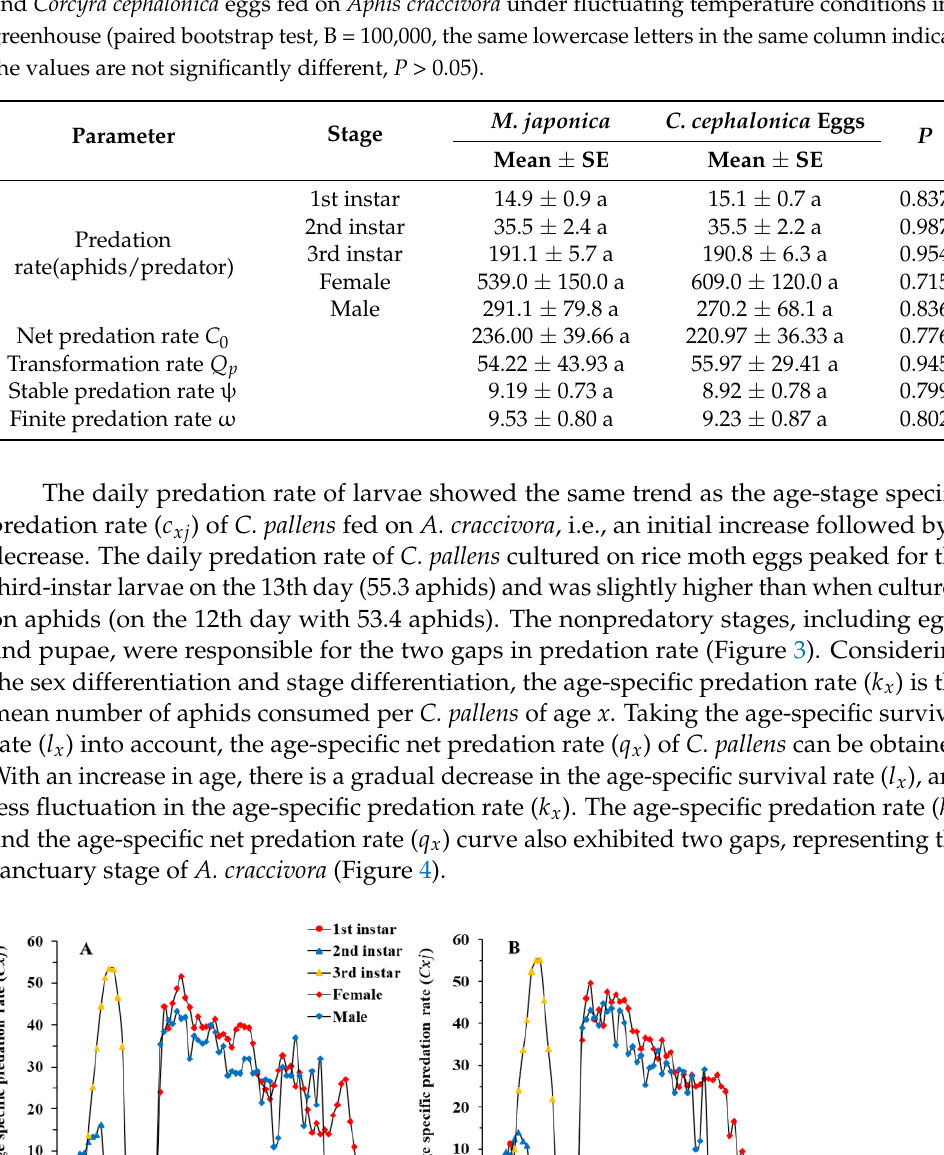
Figure 4. Age-specific survival rate ( 𝑙 𝑥 ), age-specific predation rate ( 𝑘 𝑥 ), and age-specific net preda- tion rate ( 𝑞 𝑥 ) of Chrysopa pallens ever cultured on Megoura japonica ( A ) and Corcyra cephalonica eggs ( B ) under fluctuating temperature conditions in a greenhouse. The mean and standard errors of the predation rate parameters estimated by means of the bootstrap technique [63] are listed in Table 3. There were no significant differences in the main predation rate parameters between both treatments after incorporating the survival rates and predation rates. The net predation rate ( 𝐶 0 ) of C. pallens cultured on aphid food (M. japonica ) was higher than when cultured on rice moth C. cephalonica eggs. The transformation rates (𝑄 𝑝 ) of C. pallens cultured on aphid food ( M. japonica ) and rice moth C. cephalonica eggs were 54.22 and 55.97, respectively (Table 3). 4. Discussion The use of banker plants was developed to increase the effectiveness of BCAs in pest control [24,25]. Most studies on banker plant systems have focused on assessing the suit- ability of a plant species as a banker plant [63–65] or the fitness of alternative prey on natural enemies [25,66]. Conversely, studies on the population fitness of BCAs in banker plant systems using alternative prey have received less attention. Yet, with the mass pro- duction of BCAs in biocontrol application systems, the population fitness and pest control performance of BCAs in banker plant systems are crucial when developing IPM strategies. The growth rate, stage differentiation and development, fecundity, and predation rate of predatory natural enemies in the field are key to determining their biological control effi- ciency [67]. The age-stage, two-sex life table is a promising research tool that can be used to accurately assess the effects of different food sources and environmental conditions on BCAs [45]. In the present study, we showed that C. pallens could complete its development while preying on A. craccivora in a summer greenhouse. Moreover, no significant differ- ences were found in the population and predation rate parameters of C. pallens when cul- tured on either aphid food with M. japonica or egg food in the case of C. cephalonica eggs.